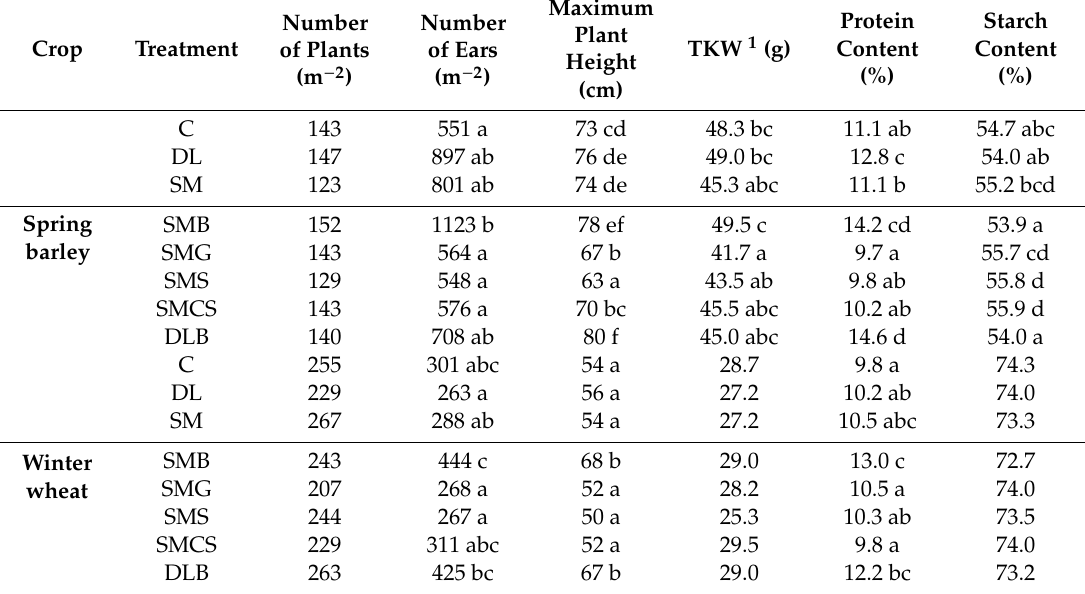
Table 5. Yield parameters of spring barley (2017, year 1) and winter wheat (2018, year 2). Di ff erent letters indicate significant di ff erences between the treatments in each year ( p < 0.05, Tukey’s